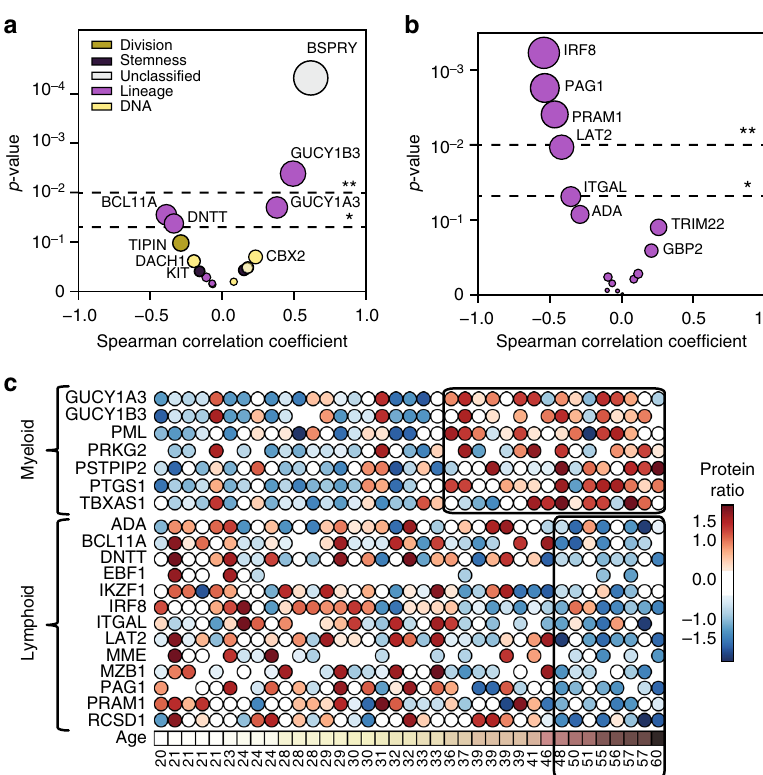
Fig. 5 Age-related alterations of lineage-speci fi c proteins in HPCs. a Scatter plot of the relationship between Spearman ’ s rank correlation coef fi cient ( x - axis) and the corresponding p value of proteins speci fi cally expressed in HPCs ( y -axis). The colour assigned to each bubble is indicative of its function, as explained in the upper left legend. The area of the bubbles represents the signi fi cance level ( p value ( − log10)). The stars at the dashed lines indicate a p value of 0.05 (*) and 0.01 (**). b Scatter plot similar to a , with proteins associated with common lymphoid progenitors (CLP) compared to megakaryocytic and erythroid progenitors (MEP), common myeloid progenitors (CMP), and haematopoietic stem cells/multipotent progenitors (HSC/MPP) in accordance with the GO annotation of immune system process (GO:0002376) 10 . c Signi fi cant alterations of the proteome landscape of HPCs upon ageing. Each circle represents a successful quanti fi cation in an individual human subject, with the respective age noted at the bottom. The colour codes for the z -score of relative intensity vs. the internal standard (TMT protein ratio), with red indicating an increase and blue a decrease in abundance upon ageing. The boxes indicate the age boundaries where the majority of the respective age-dependent increase or decrease in protein abundance takes